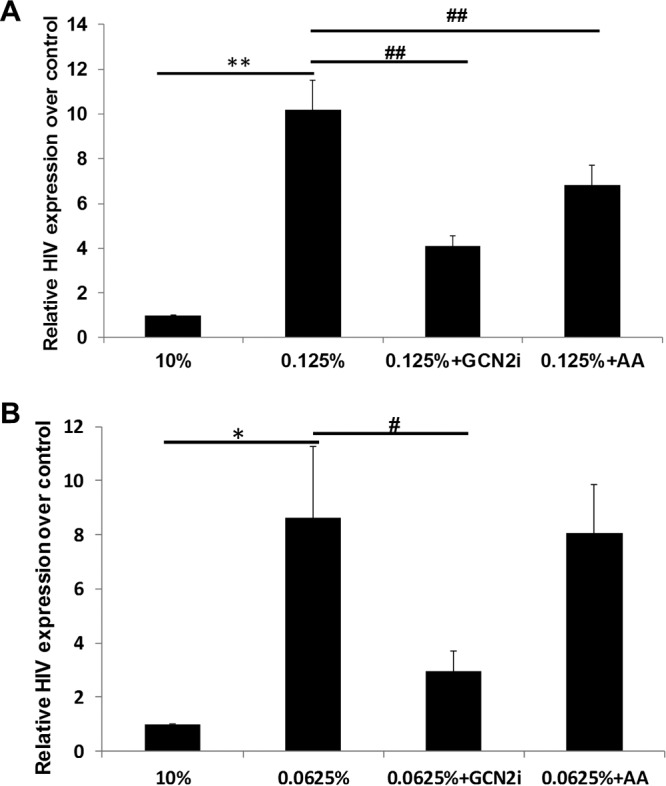
Suppression of GCN2 or amino acid supplementation inhibits induction of HIV expression. J-Lat A1 (A) or U1 (B) cells were nutrient deprived in medium with low levels of serum (0.125% of FBS in medium) in the presence of 10 μM GCN2 inhibitor (SP600125) or 1 mM amino acids (Phe/Lys) for 48 h, and HIV expression was evaluated by qPCR. *, P < 0.05; **, P < 0.01, compared with 10% FBS medium control; #, P < 0.05; ##, P < 0.01, compared with nutrient deprivation (0.125% [A] and 0.062% [B]). Experiments were performed a minimum of three times.